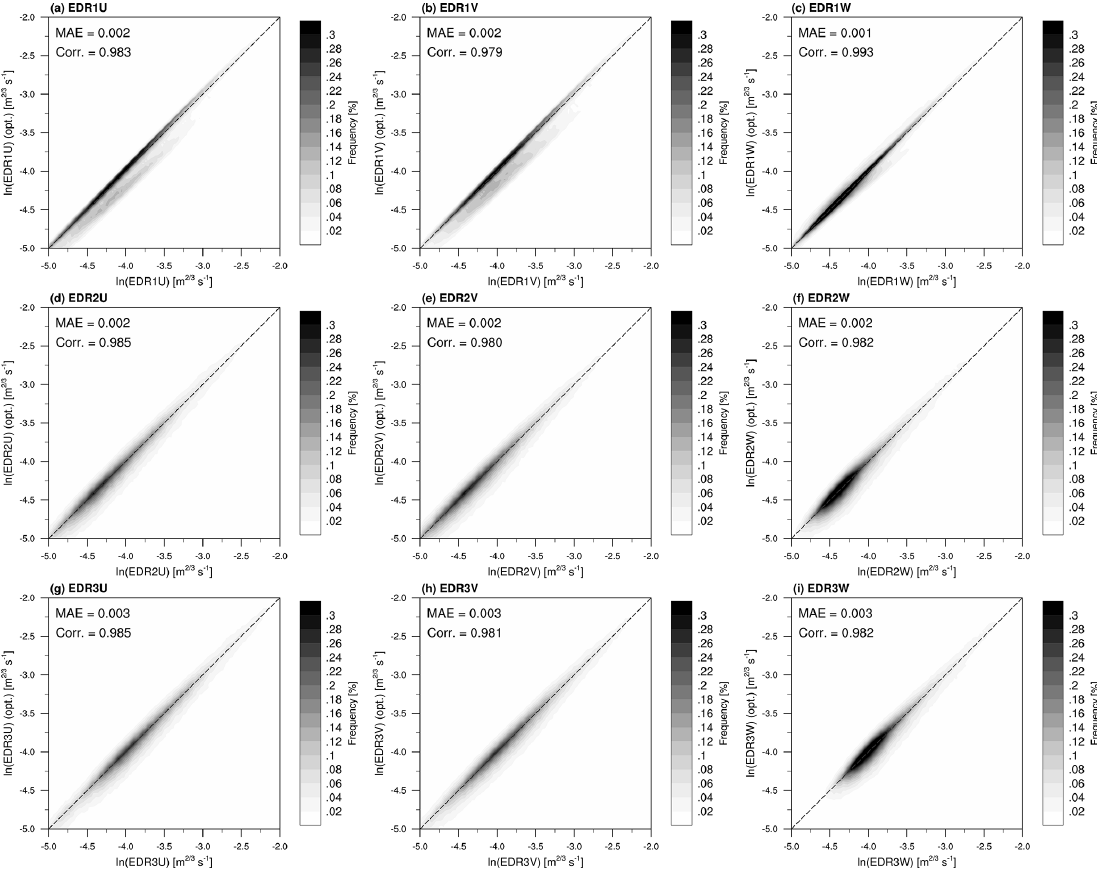
Figure 4. Scatter density plots of the EDRs – (a–c) EDR1s, (d–f) EDR2s, and (g–i) EDR3s – using the fixed inertial range and dynamic inertial range for the B777. Pearson correlation and MAE are given in the top-left corner of each